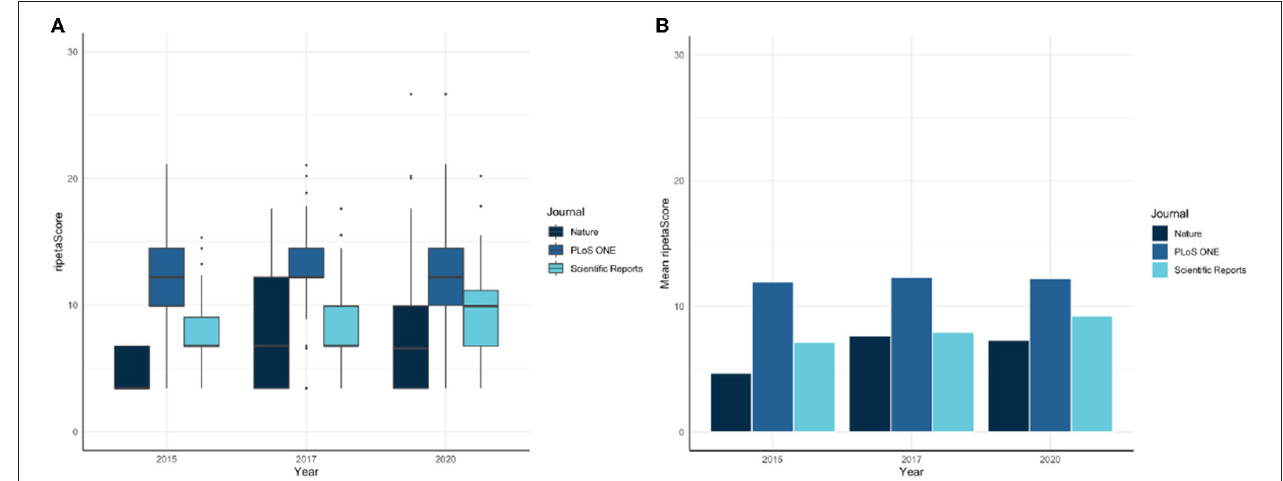
FIGURE 4 | (A,B) RipetaScore comparison across Nature, PloS One, and Scientific Reports.